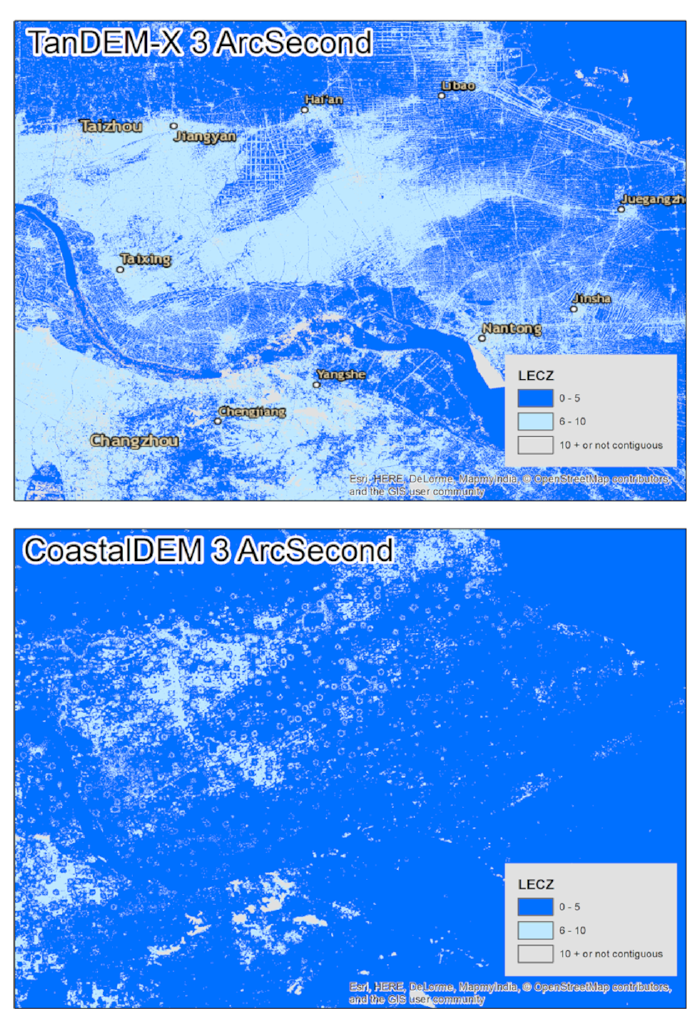
Figure B2. Raw TanDEM-X captures roadways, whereas CoastalDEM seems to capture agricultural land uses.